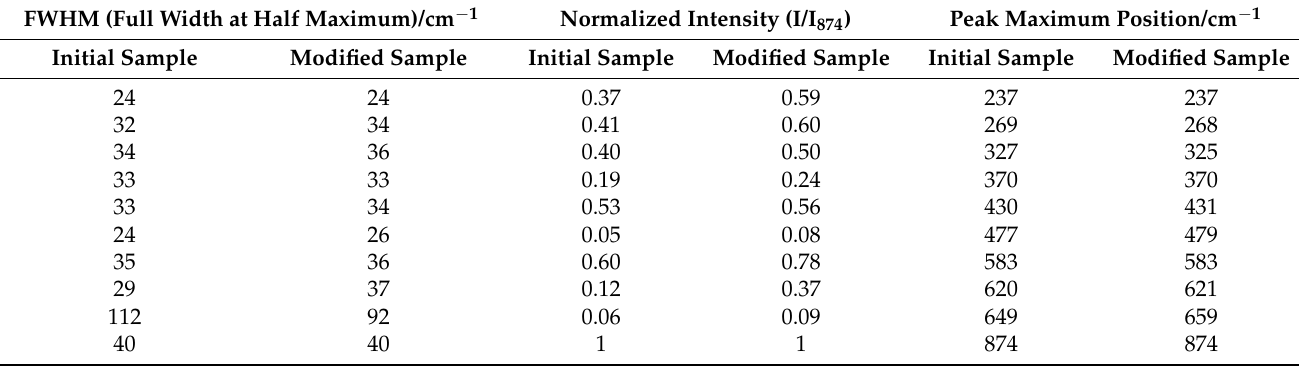
Table 1. Parameters of vibrational bands in the Raman spectra of the initial and modified LiNbO 3 single crystal samples.